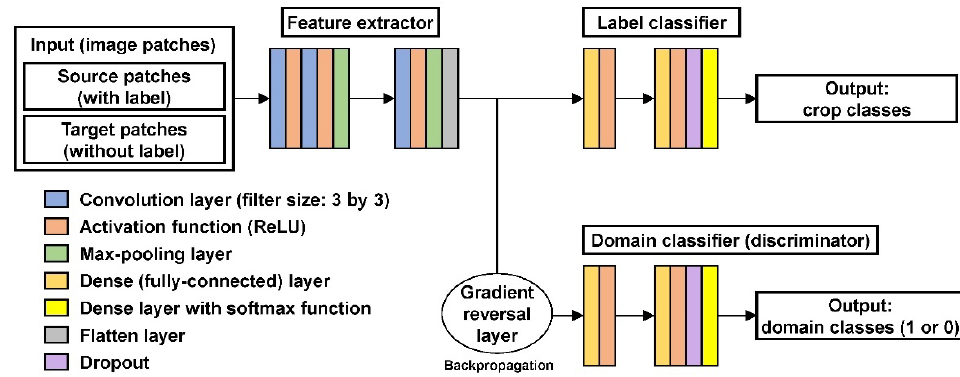
Figure 2. The DANN network architectures employed in this study.